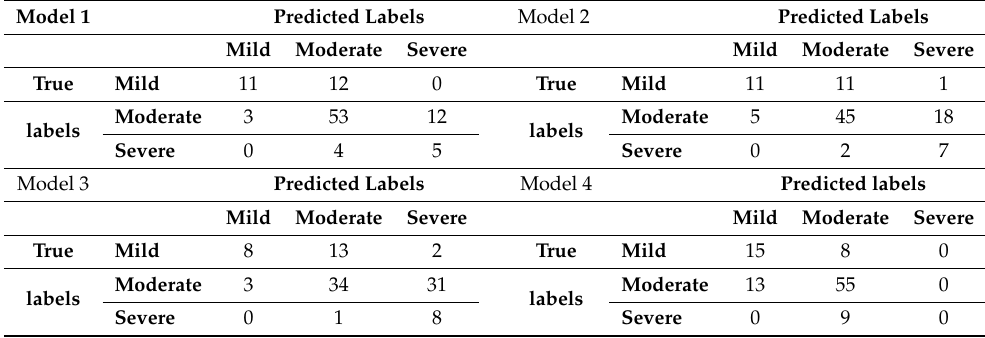
Table 3. Confusion matrices of best models on the test set. In bold the model with the best trade-off between accuracy and no-bias toward the majority